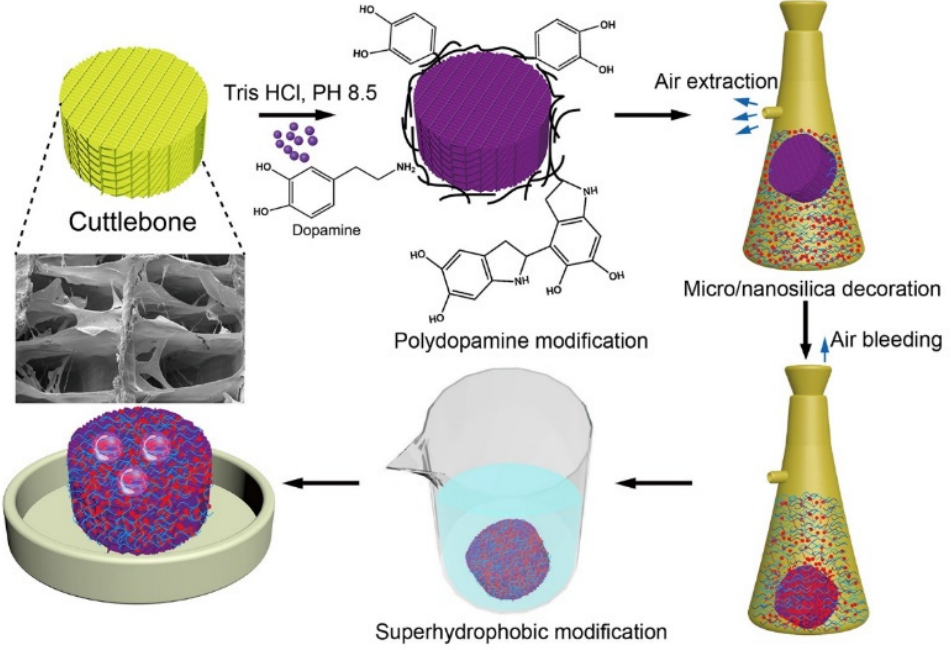
Figure 1. Schematic of surface modification of superhydrophobic and oleophilic cuttlebone cylin- ders.